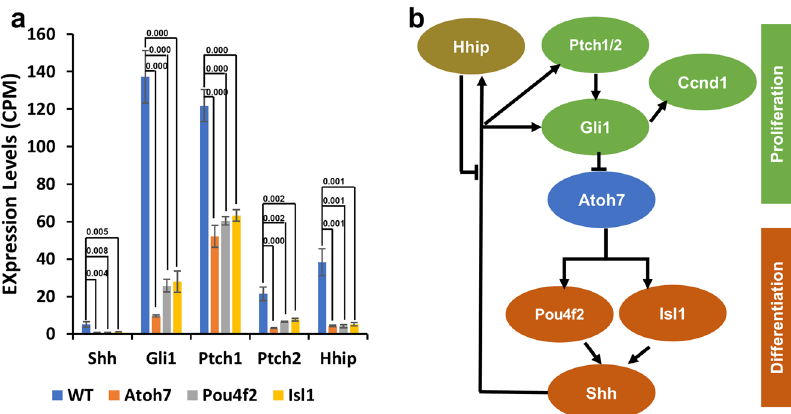
Fig. 2 The Shh pathway is regulated by the RGC gene regulatory cascade at multiple levels. a Multiple component genes of the Shh pathway are downregulated in the three mutant retinas. Data are presented as mean values ± SD. CPM: counts per million. n = 3 independent replicates for each genotype. Two-tailed Student ’ s t test with equal variance was performed between each mutant and the wild-type for each gene. P values between all mutants and wild-type are provided. Source data are provided. b A diagram showing how the Atoh7 - Pou4f2/Isl1 gene regulatory cascade regulates the Shh pathway in the developing retina in a complex manner, with multiple feedback loops.